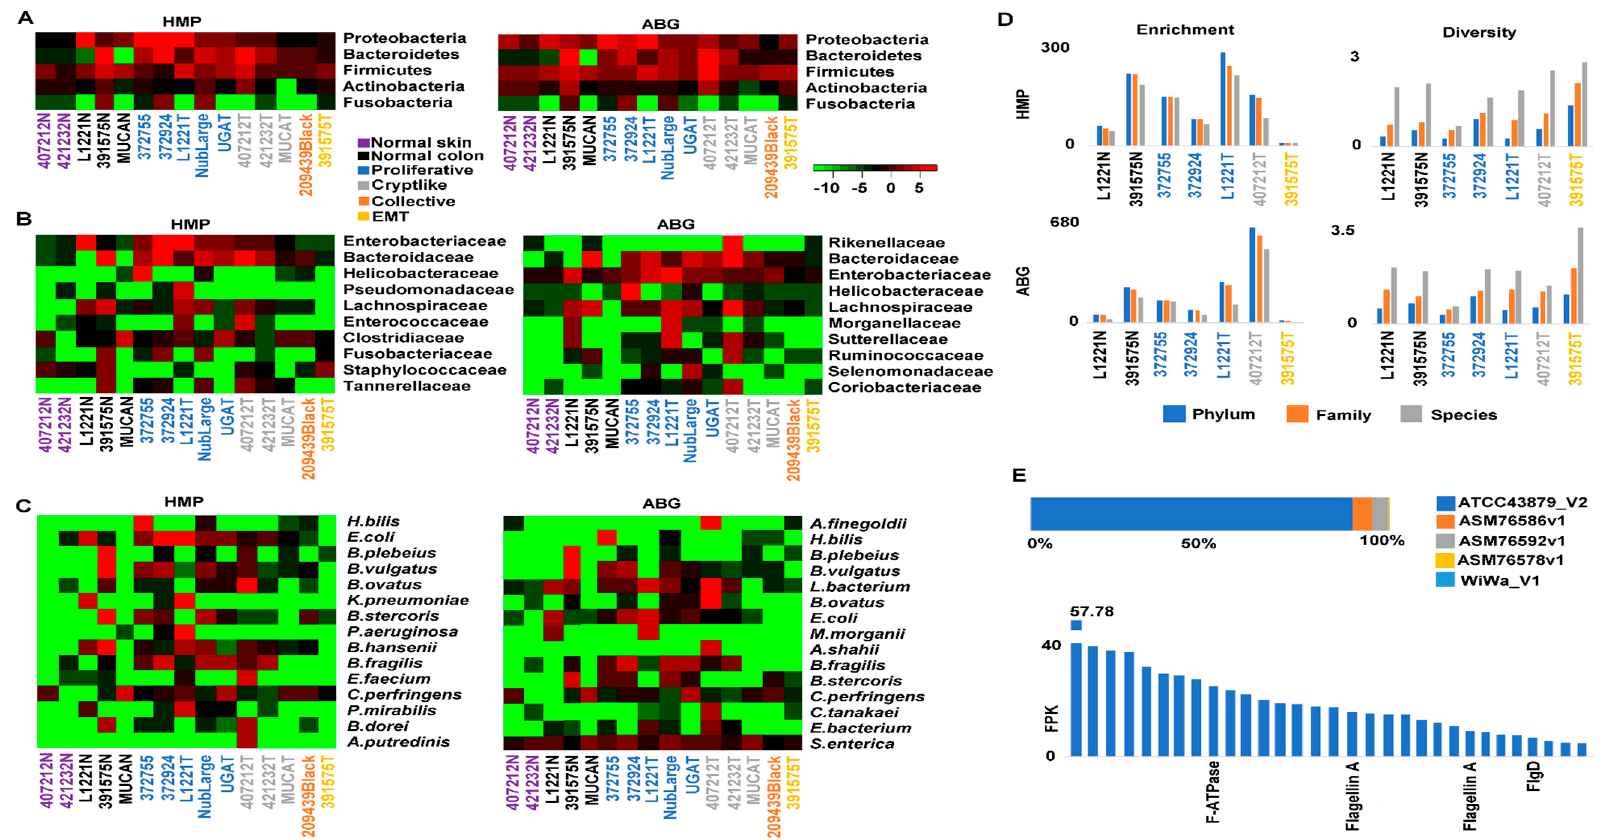
Figure 4. A crypt-like invasion tumor harbors a microbiome that resembles mucosa samples. ( A – C ) Heatmaps indicate enrichment levels (Red: enriched; green: depleted) of bacterial phylum, family and species in each sample. HMP (Human Microbiome Project) and ABG (all bacterial genomic sequences) are the two microbial databases used. Sample types are specified by the colors as indicated. ( D ) Crypt-like invasion tumor 407212T (gray), but not EMT invasion tumor 391575T (yellow), resembles normal colorectal mucosal samples (black) and proliferative tumors (blue) in bacterial enrichment and diversity. ( E ) H. bilis strain ATCC 43879 is enriched in proliferative tumor 372755 (top) and expresses genes including those encoding flagellin A (bottom). See also Table S4.